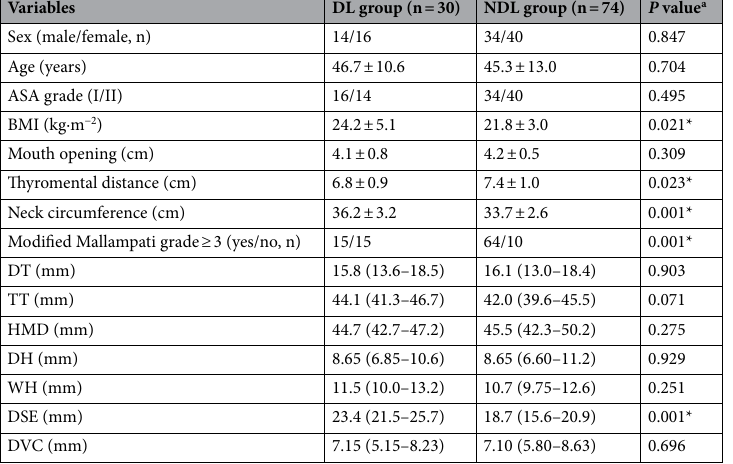
Table 2. Participant characteristics in two groups. NDL non-difficult laryngoscopy, DL difficult laryngoscopy, ASA American Society of Anesthesiologists, BMI body mass index, DT distance from skin to under surface of tongue, TT thickness of the thickest part of tongue body, HMD hyoid mental distance, DH depth of hyoid, WH width of hyoid, DSE distance from skin to epiglottis, DVC depth of the anterior combination of the vocal cords. Data are shown as the means ± SD deviation and median ( P 25 – P 75 ) or numbers. * P value < 0.05. a Patient characteristics were analyzed by Mann–Whitney U test for continuous variables and χ 2 test for categorical variables.